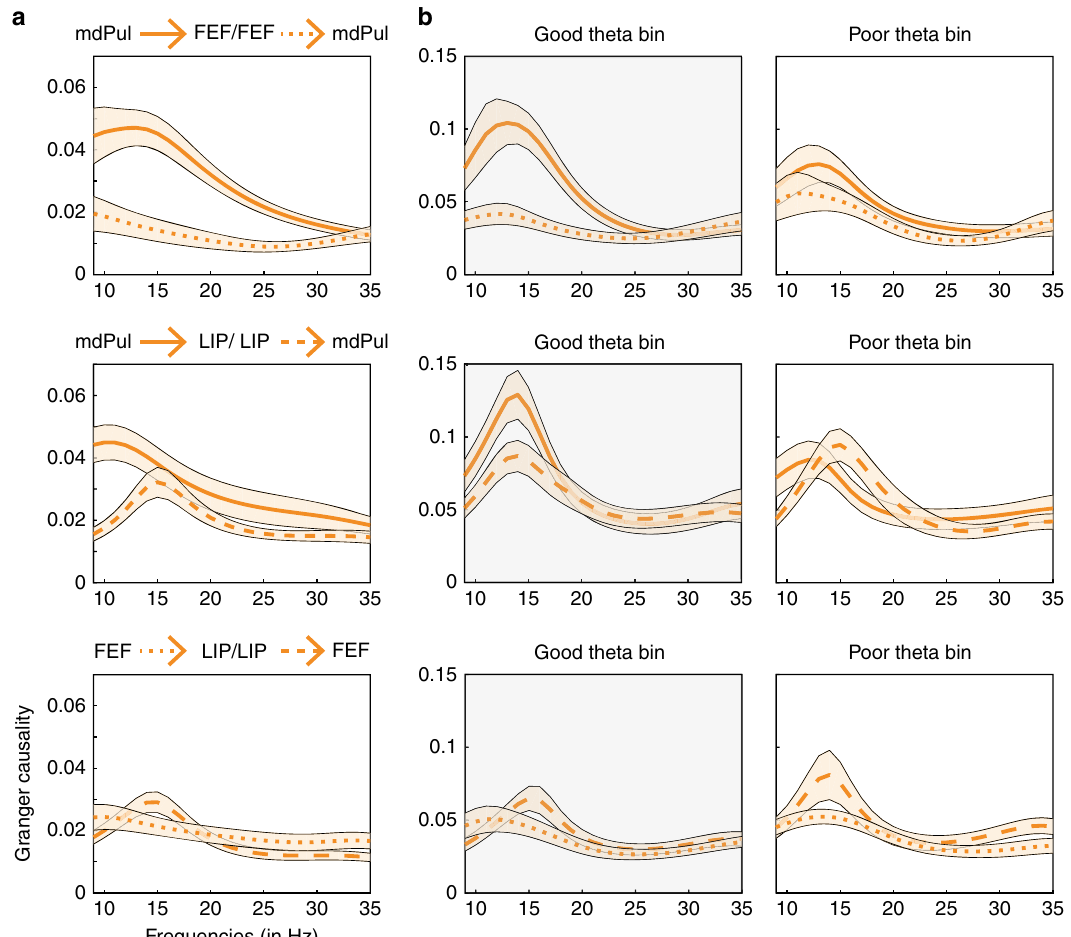
Fig. 6 Granger causal in fl uence indicates that mdPul regulates alpha/low-beta activity in cortex. a For each pair of ROIs, Granger causal in fl uence (model order = 8) was based on all recording sessions with overlapping response fi elds (mdPul vs. FEF, N = 51; mdPul vs. LIP, N = 57; FEF vs. LIP, N = 67). Supplementary Figure 4 instead shows conditional Granger causality for a subset of sessions when all three ROIs had overlapping response fi elds ( N = 31). Panel b shows Granger causal in fl uence after binning based on theta phase ( “ good ” vs. “ poor ” ). mdPul speci fi cally regulates cortical activity during periods of relatively better visual-target detection (i.e., during the “ good ” theta phase). Shaded regions around the lines represent